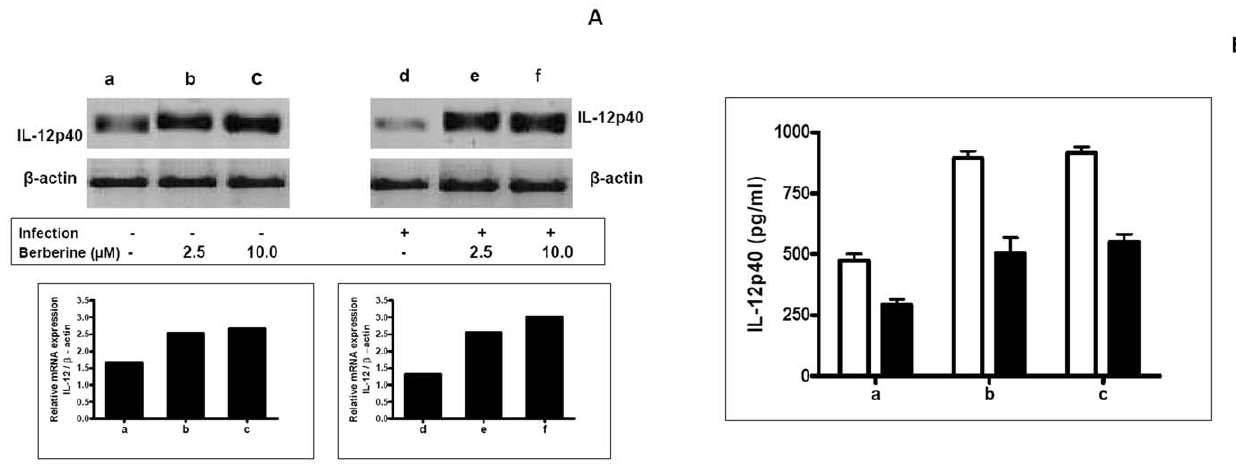
Figure 3. Effect of Berberine chloride on IL-12p40 in macrophages. A: Uninfected (a) and L. donovani infected (d) macrophages were treated for 18 h with Berberine chloride 2.5 m M (b, e) or 10 m M (c, f). RNA was isolated, subjected to RT-PCR and the products of b -actin and IL-12 p40 mRNA were resolved on an agarose gel (1.5%) and quantified densitometrically using Total lab software as described in Methods. B: Uninfected macrophages (1 6 10 6 /ml, % , a) or L. donovani infected macrophages ( & , a) were treated with Berberine chloride 2.5 m M (b) and 10 m M (c) for 24 h and assayed for levels of IL-12p40 in culture supernatants by ELISA as described in Methods. Each point represents the mean 6 SEM of IL-12p40 (pg/ ml) of at least 3 experiments in duplicate.